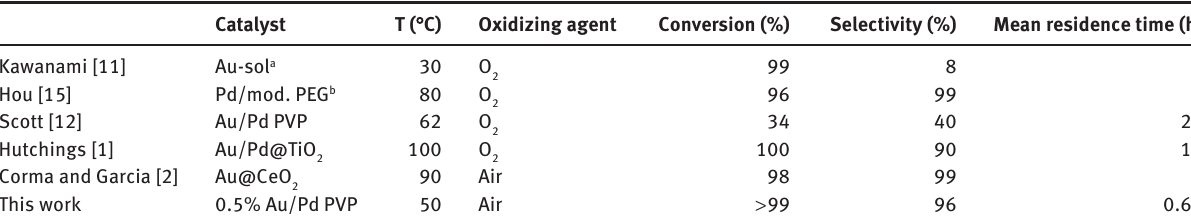
Table 2 Comparison of the results at hand with procedures reported in literature at 1 bar.